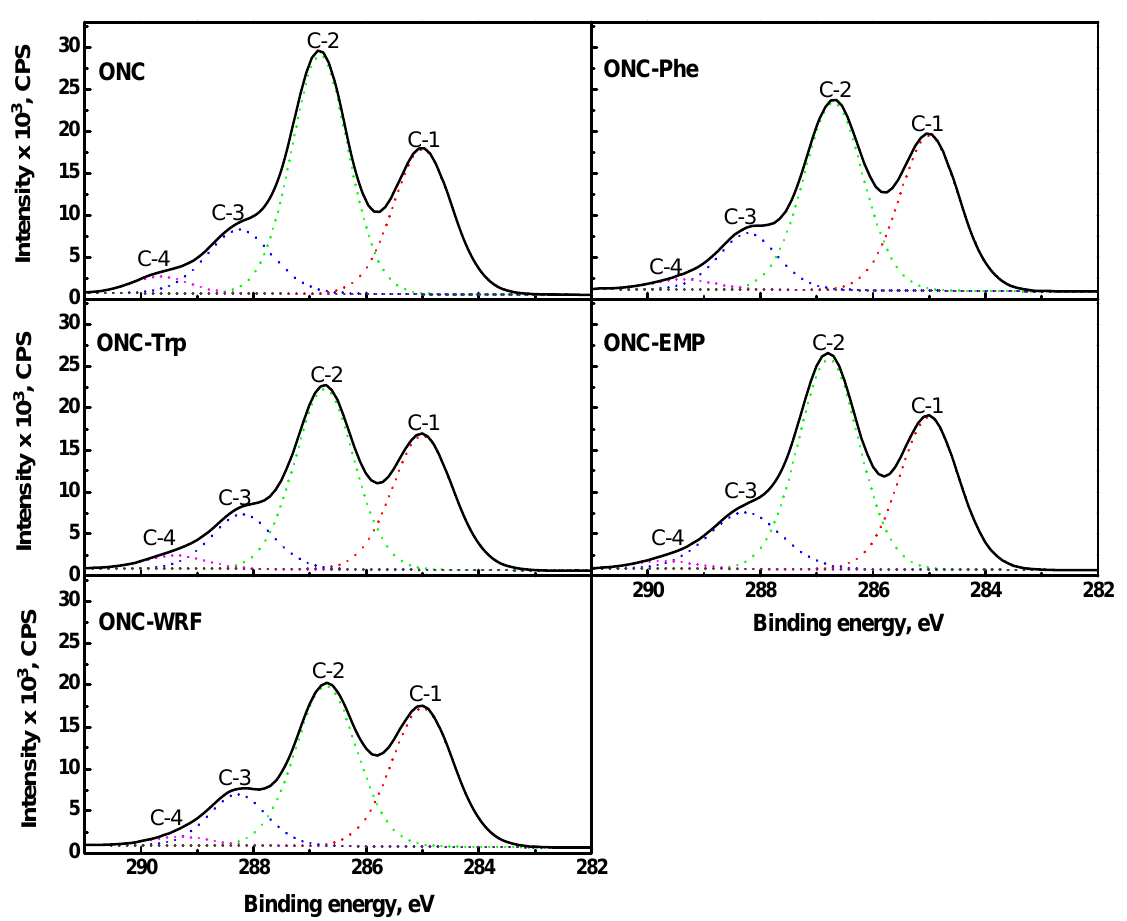
Figure 7. C 1s narrow scan XPS spectra for ONC, ONC-Phe, ONC-EMP, ONC-Trp and